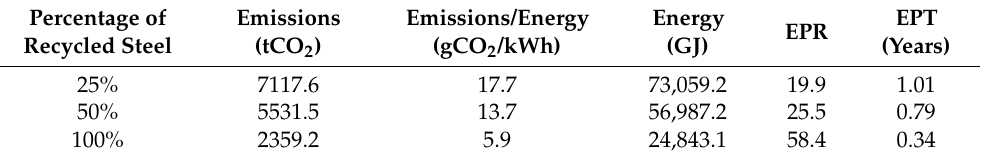
Table 8. CO 2 emissions and energy consumption for the project considering different levels of recycled steel.